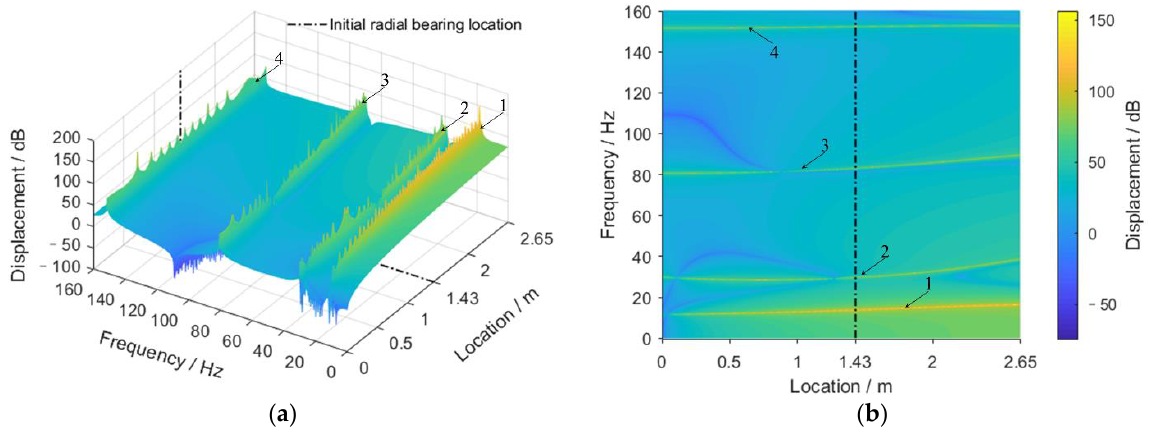
Figure 8. Transverse vibration under different radial bearing stiffness. ( a , b ) are the vibration response at 𝑥 = 0 m . ( b ) is the top view. Numbers and arrows are used to mark the order of the resonance.